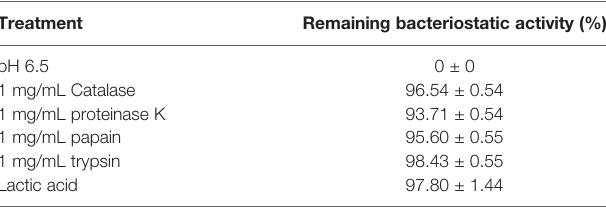
TABLE 1 | Effects of catalase, protease treatment, pH, and Lactic acid on the bacteriostatic activity of the CFS derived from L. plantarum KLDS 1.0344. Treatment